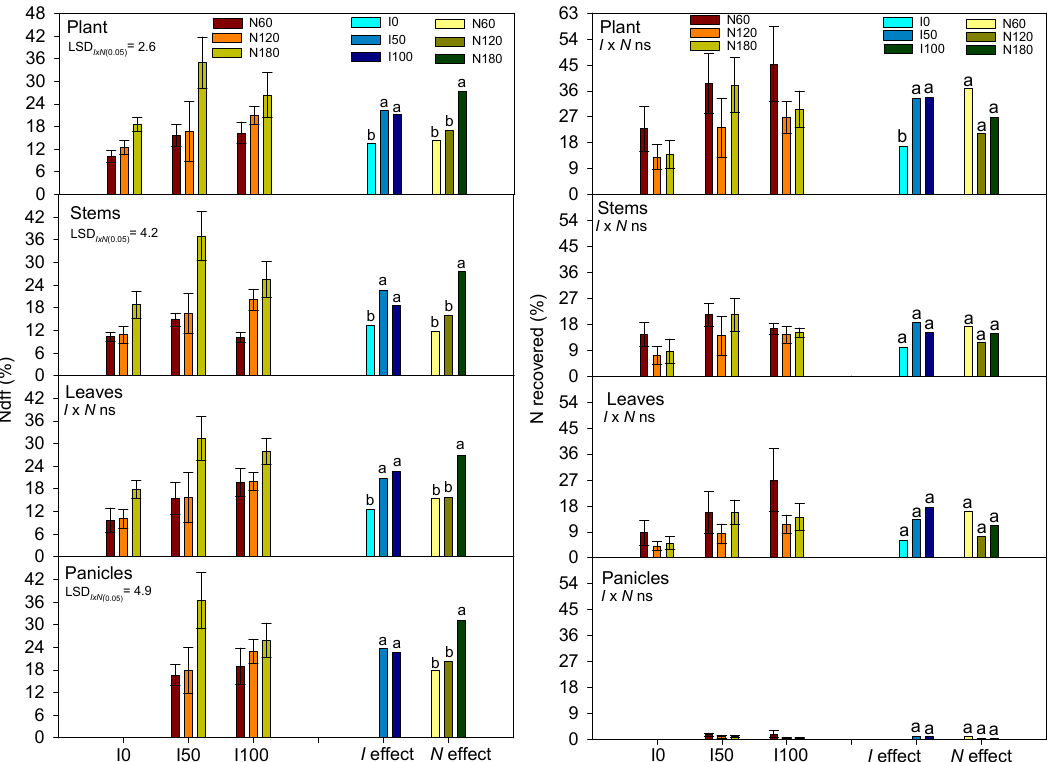
Figure 2. Plant N from the fertilizer ( Ndff , %) compared to total plant N and uptake rate of N applied by fertilization (N recovered, %) in relation to irrigation (I0, I50, I00 = 0, 50, 100% ETc, respectively) and the N levels (N60, N120, N180 = 60, 120, 180 kg ha − 1 N) in sweet sorghum cv. Keller. Different letters for the main effects ( I = irrigation; N = N level) indicate significant differences at p ≤ 0.05. Black vertical bars indicate the standard error.